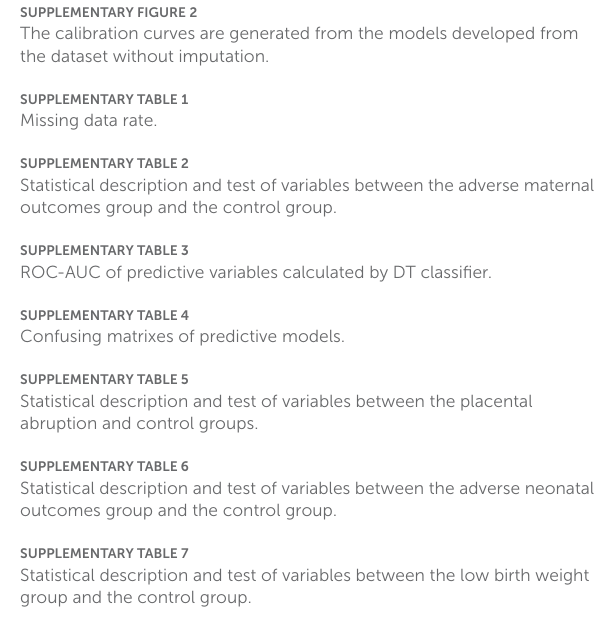
SUPPLEMENTARYTABLE7 Statistical description and test of variables between the low birth weight group and the control